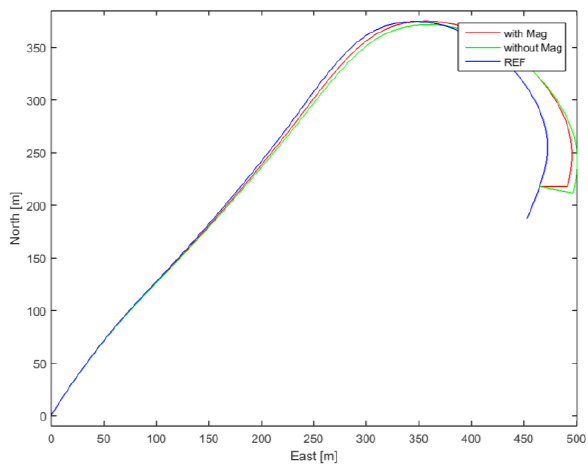
Position RMSE [m] Figure 10. Portion of the trajectory during RTK signal outage using ADIS Figure 11 depicts the position error in the East, North, and Down directions between the reference and the INS/RTK integration with magnetometer and without magnetometer during the RTK signal outage period. The RMS errors in the East, North, and Down directions are 11.53, 0.50, 0.81 m and 14.51, 3.18, 2.07 m respectively as shown in Table 4. The green line states the INS/RTK integration without magnetometer, and Table 2. PA RMSE for the IMUs using RTK or GPS position the INS/RTK integration with magnetometer is presented by the update red line.